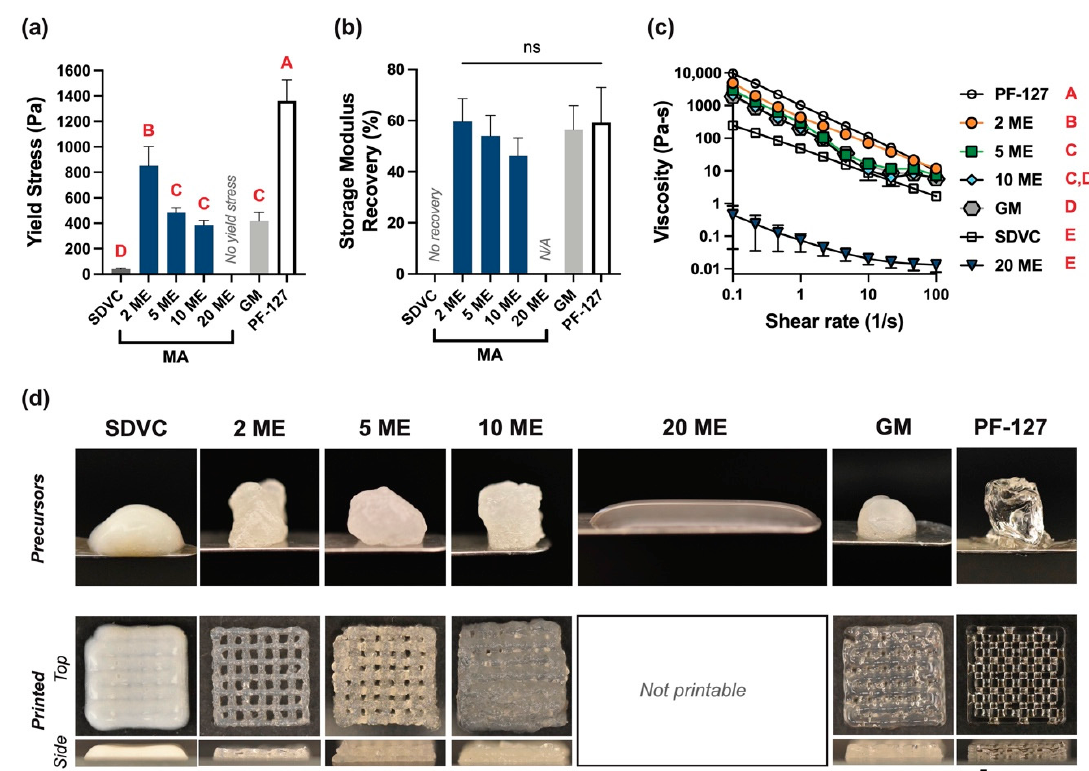
Figure 5. Most MeSDVCs had paste-like precursors, with the 2-fold molar excess MA and GM MeS- DVCs printing the best grids. The MeSDVC precursors, along with unfunctionalized SDVC and Pluronic™ F-127 (PF-127) for comparison, were characterized with three rheological tests: ( a ) yield stress, ( b ) storage modulus recovery, and ( c ) viscosity. The 2 ME MA MeSDVC precursor had a greater yield stress and viscosity than those of all other MeSDVCs and SDVCs. Interestingly, the 20 ME MA MeSDVC did not have a detectable yield stress and had significantly lower viscosity than all other groups, which we speculate may have been due to the higher functionalization preventing collagens present in the MeSDVC from forming triple helices. ( d ) The paste-like precursors of MeS- DVC, SDVC, and PF-127 are visualized on spatulas (top row) and were printed into four-layer grids to assess printability (bottom row). The 5 ME and 10 ME of MA MeSDVCs tended to clog the nozzle and overprint, while the 2 ME MA MeSDVC and the GM printed with the best shape fidelity. Scale bar: 5 mm. Different letters indicate significance from each other ( p < 0.05). ns = no significance across all